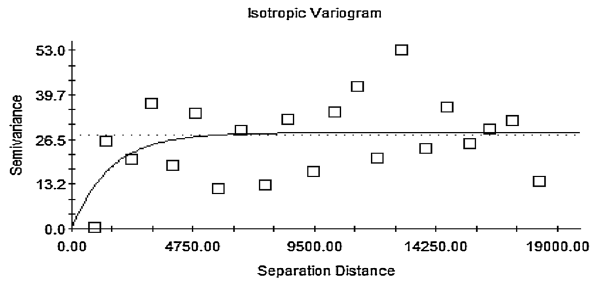
Fig. 3 Histogram of the water saturation data. The frequency distri- bution curve related to the water saturation data